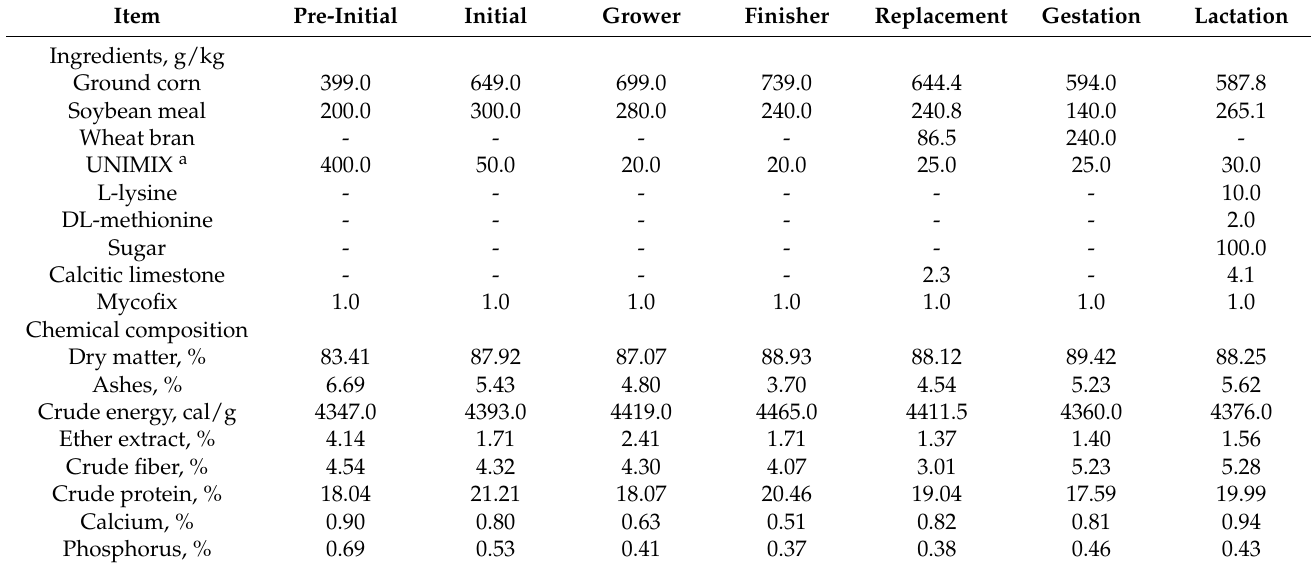
Table 2. Composition of pre-initial, initial, grower and finisher diets, specific to each physiological phase of swine females.